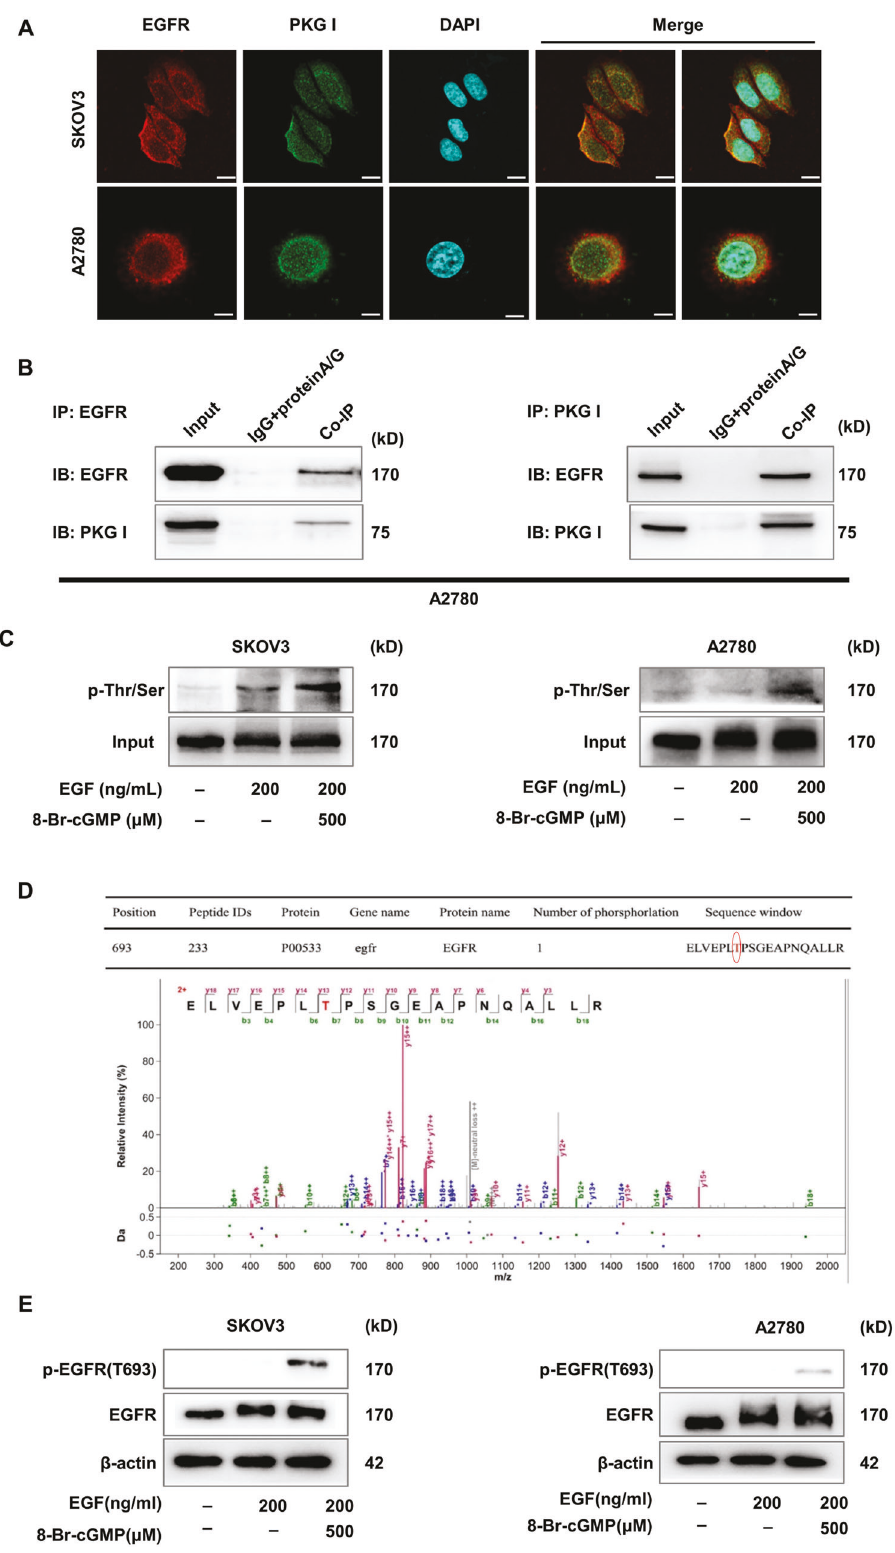
Fig. 5 Activated PKG I bound with EGFR leading its serine and threonine phosphorylation. A Confocal laser scanning microscopy images on the expressions of EGFR and PKG I in SKOV3 and A2780 cells. Scale bar, 5 μ m. B Co-IP assay revealed that PKG I bounded with EGFR in SKOV3 and A2780 cells. C Immunoprecipitation assay the serine and threonine phosphorylation of EGFR in SKOV3 and A2780 cells. D Mass spectrometry analysis identi fi ed that activated PKG I caused threonine 693 phosphorylation of EGFR. E Western blot analysis showed that activated PKG I caused phosphorylation of EGFR threonine 693 site in SKOV3 and A2780 cells.